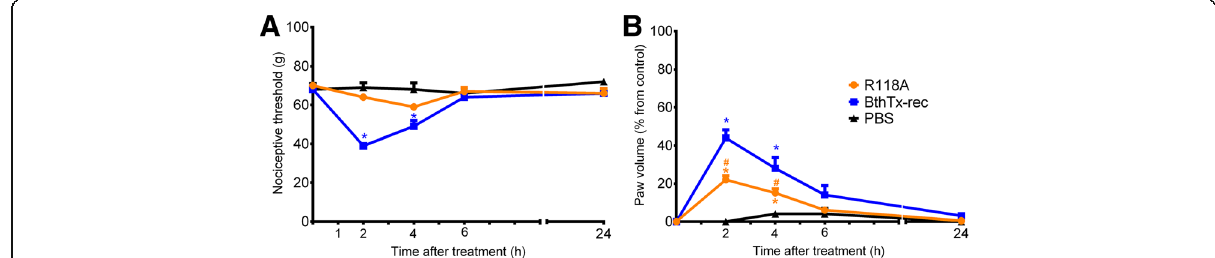
Fig. 2 Effect of BthTx-I R118A (Arg118 → Ala) mutagenesis on rat pain threshold and paw volume. Decrease in a threshold response and b paw volume were determined in rat hind paw before and 2, 4, 6 and 24 h after the intraplantar injection of PBS (control group) or R118A, or recombinant BthTx-I. The paw volume was obtained pletsmografically. Sensitivity to pain was measured as the threshold response to pressure and expressed as g . The paw volume was obtained pletsmografically. Each point represents the mean±SEM of six animals. *Significantly different from mean values before venom injection and #different from BthTx-I-recombinant (BthTx-I rec) ( p<